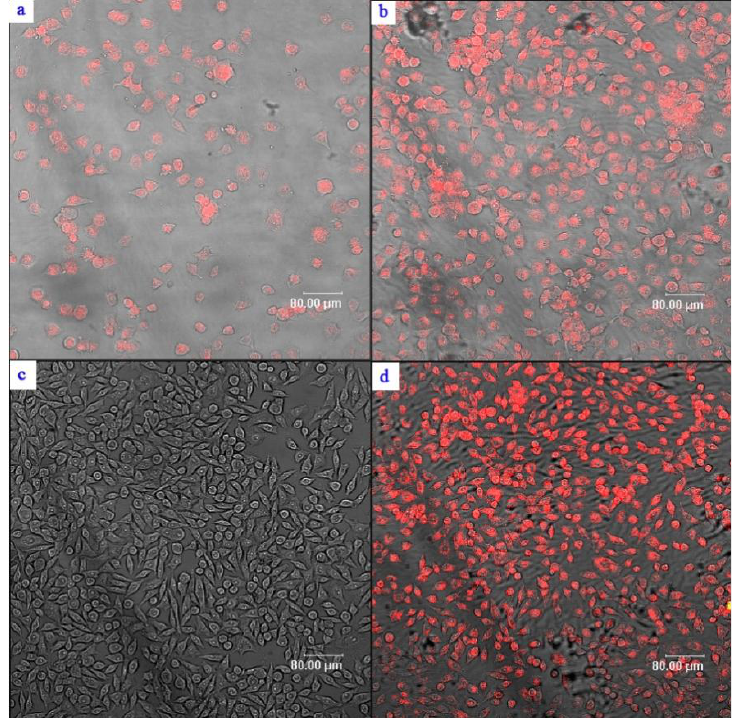
Figure 5. CLSM images of MCF-7 cells cultured with DOX and DOX − HT 42 − CS − DCA 3.2 nanoparticles (5 μg/mL of DOX): ( a ) free DOX after 2 h incubation; ( b ) free DOX after 5 h incubation; ( c ) DOX − HT 42 − CS − DCA 3.2 nanoparticles after 2 h incubation; ( d ) DOX − HT 42 − CS − DCA 3.2 after 5 h incubation.